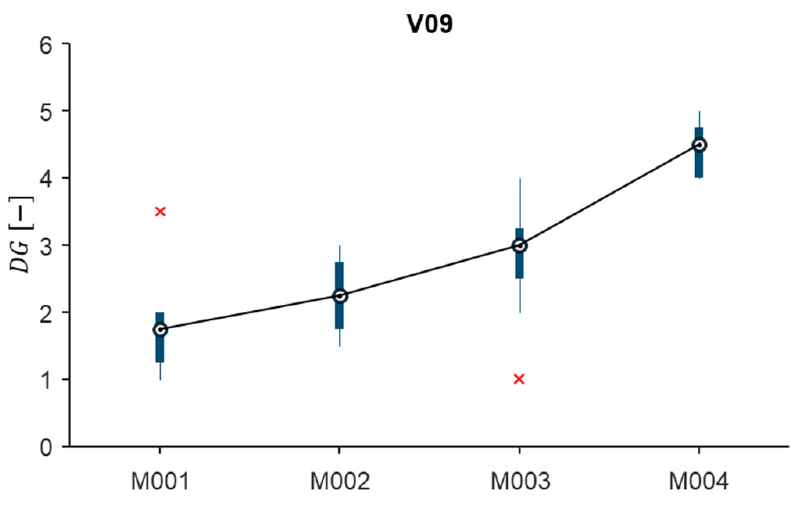
Figure 7. Assessed damage grade ( DG ) of test V09 of a 51305 axial ball bearing with axial load F A = 1 kN and rotational speed n = 2500 rpm with an applied square wave voltage ˆ V = 2.5 V at f = 5 kHz after 3 h (M001), 6 h (M002), 9 h (M003) and 21 h (M004) of electric damaging. Circles mark the median, boxes mark the interquartile range, vertical lines mark the overall range of values and crosses mark outliers.